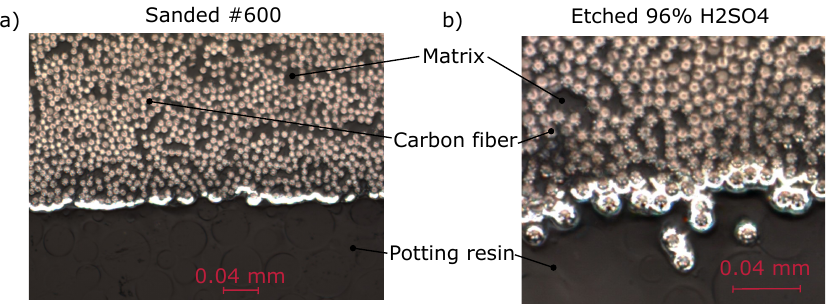
Figure 12. Microscopy study of ( a ) sanded and ( b ) etched surfaces contacted with